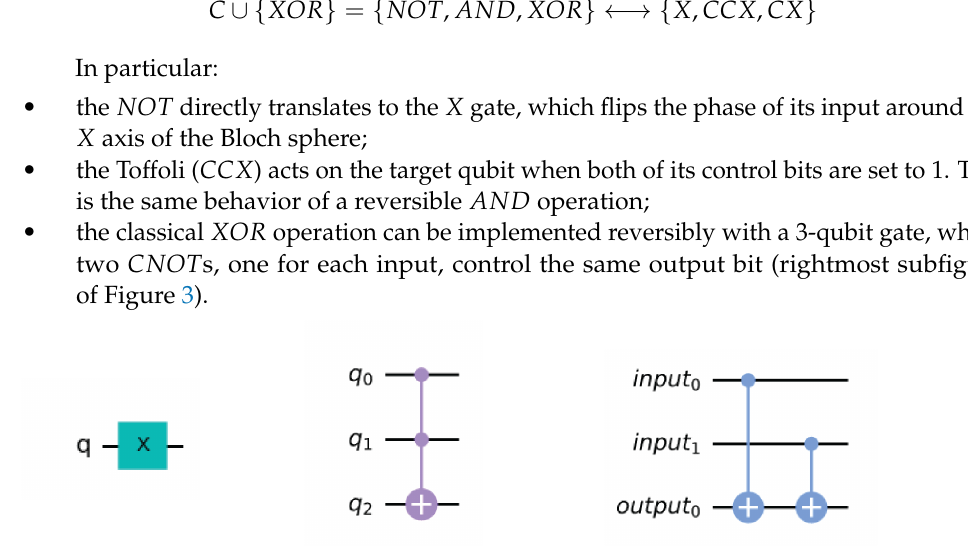
Figure 3. Structure of the { NOT , AND , XOR } gates as quantum circuits. From left to right: the X gate; the Toffoli, and the XOR gate. The target qubit of the Toffoli gate, | q 2 (cid:105) , stores the values | q ⊕ ( q · q ) (cid:105) . For the XOR gate, | output 2 0 1 cases, in order to preserve the actual value of the operations, the qubits that store the result, namely | q (cid:105) and | output (cid:105) , are initialized to | 0 (cid:105) , so that their state after the gate is simply | q 2 0 | input ⊕ input (cid:105) 0 1